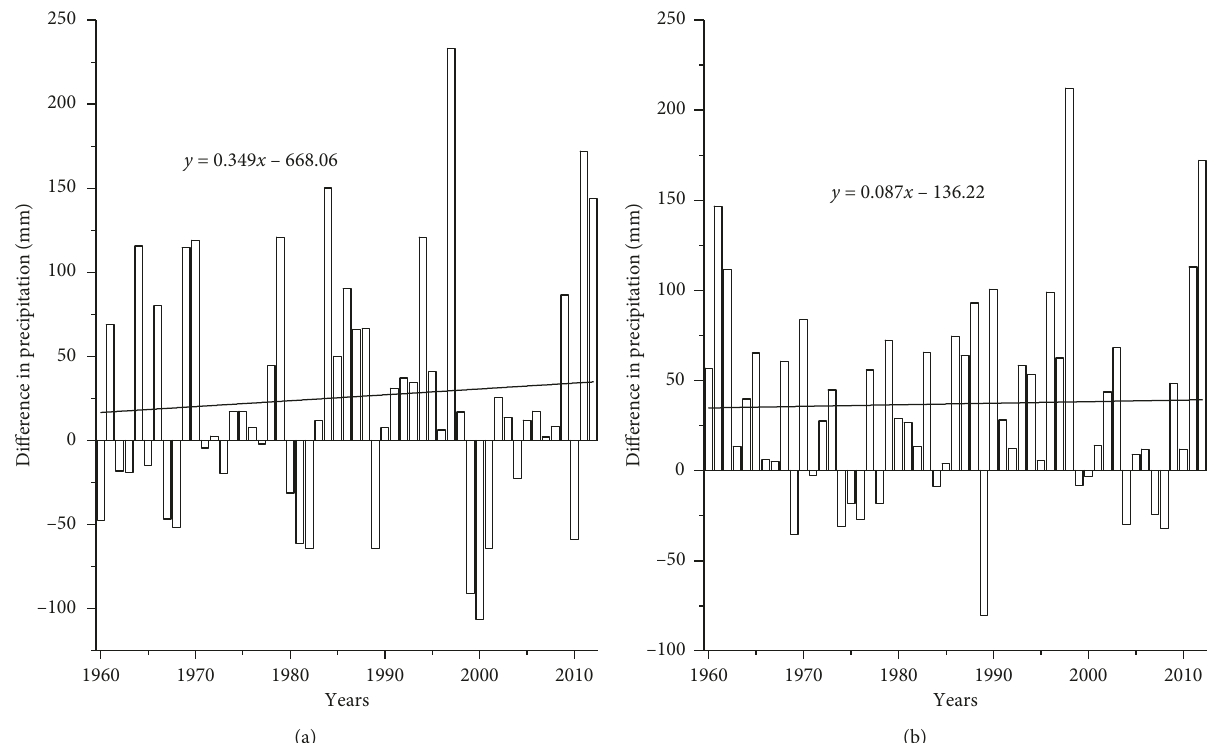
Figure 12: Differences in precipitation and their linear trends: (a) between the plain and mountain areas, (b) between the urban and suburban